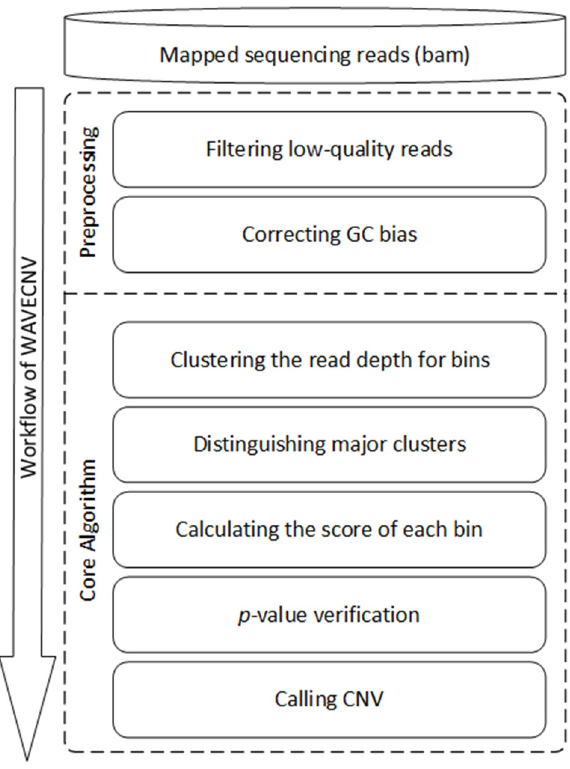
Figure 1. The workflow of WAVECNV.